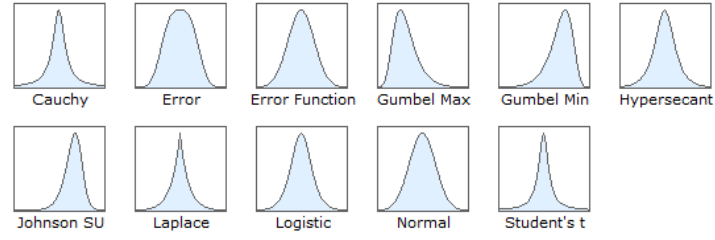
Figure 6. Basic shapes of each